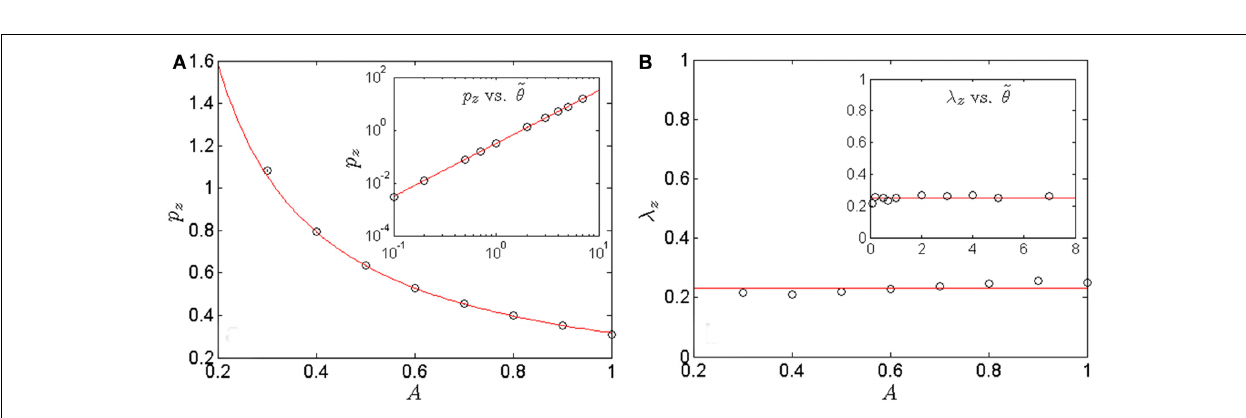
λ z associated with the curve S z vs .(cid:17) z as a function of A at constant ˜ θ = 1 (main) and as a function of ˜ θ at constant A = 1 (inset). In both graphs, the red lines correspond to fits λ z = 0 . 24 ± 0 . 03. Here, ± indicates a 95% confident